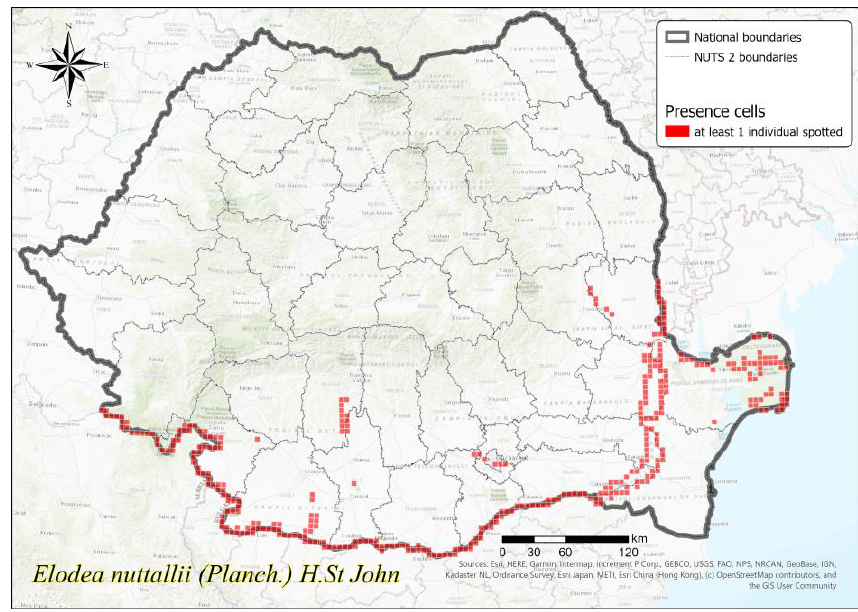
Fig. 4. Elodea nuttallii occurs along the River Danube and some